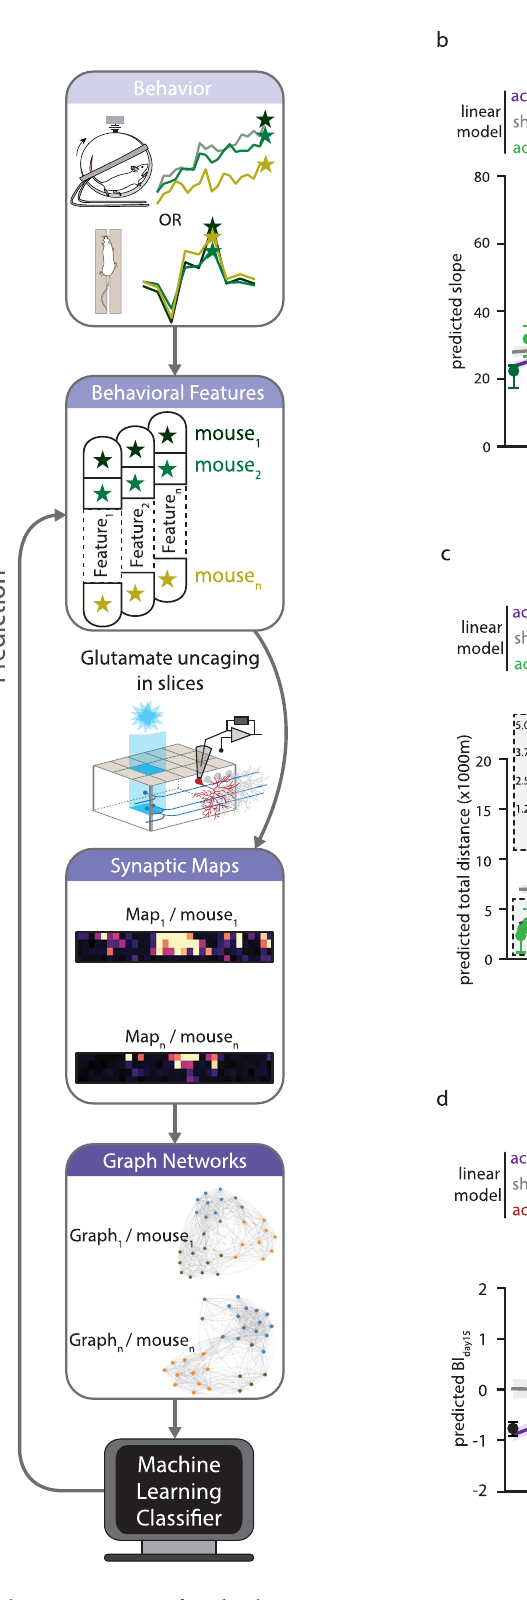
(Fig. 6c), while they were worse for the long training groups (Fig. 6c), possibly re fl ecting non-linear relations that the GLM framework cannot capture. The MSE for the slope followed a similar trend, for pooled data, 224.5 ± 24.7 (actual) vs 451.8 ± 75.6 (shuf fl ed, Fig. 6b). The MSE are lower when only long training data is considered but worse when only short training data is